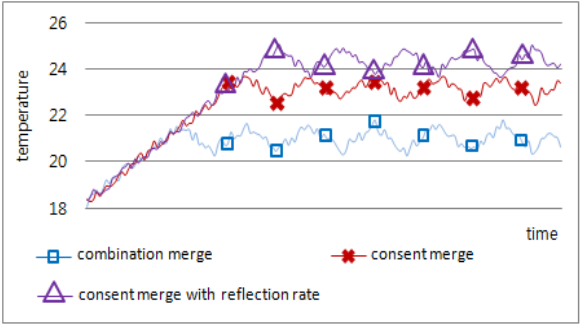
Fig. 3. The change of temperatures in the room.